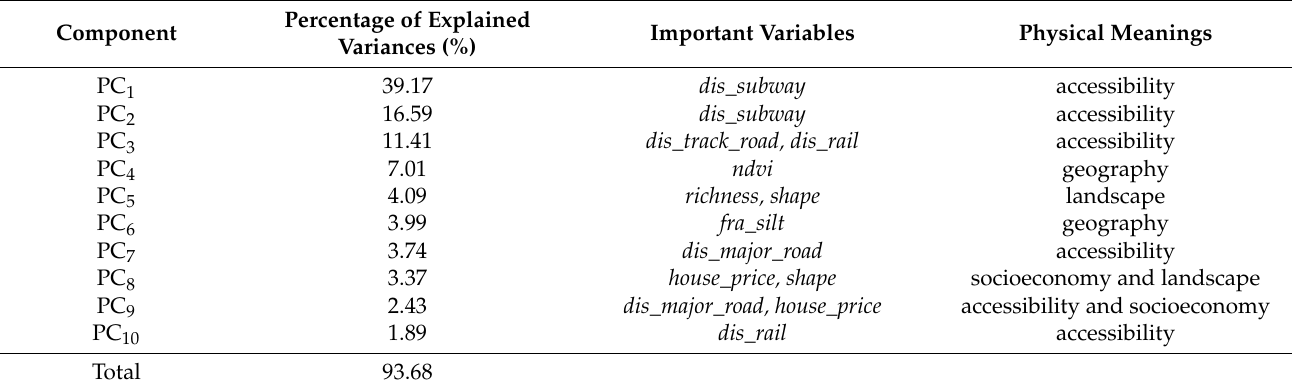
Table 7. Summary of the extracted ten components from PCA. Important variables with a loading factor higher than 0.50 are